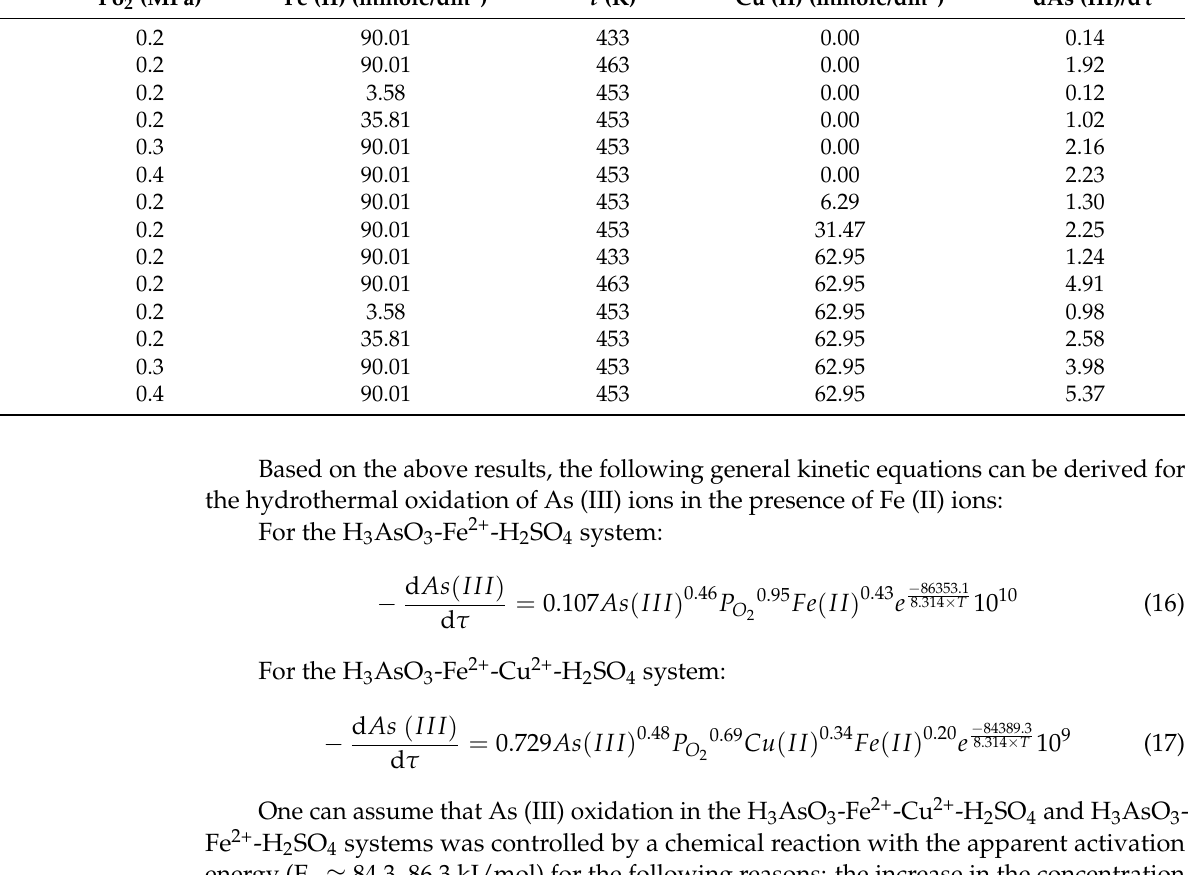
Figure 12. Graphical determination of the k o coefficient for H 3 AsO 3 -Fe 2+ -H 2 SO 4 ( a ) and H 3 AsO 3 -Fe 2+ -Cu 2+ -H 2 SO 4 ( b ) systems. Table 2. Kinetic data at different parameters for oxidation efficiency of As (III) to As (V).